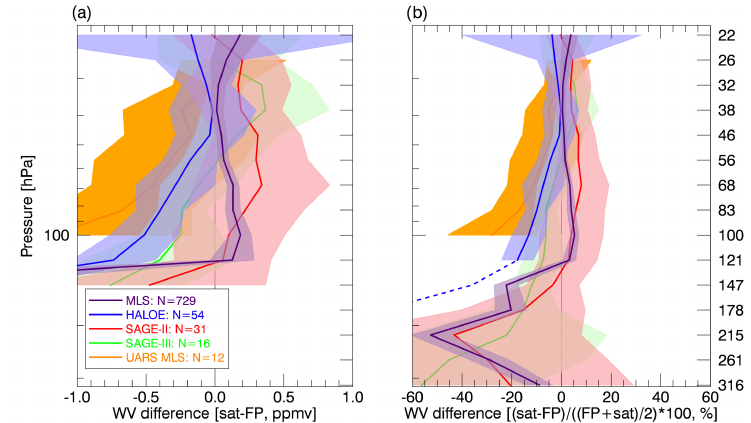
Figure 3. The difference as a function of height between matched satellite and balloon frost point (FP) hygrometer water vapor (WV) data, expressed (a) as a mixing ratio difference and (b) as a percent difference between the mean value at each level (see discussion in Sect. 3.1). The number of matches at 82hPa is shown in the legend, and the mean difference (solid) and ± 2 standard error (2 σ/ shown at each level. The dashed blue line shows the HALOE data that are excluded from SWOOSH, at and below